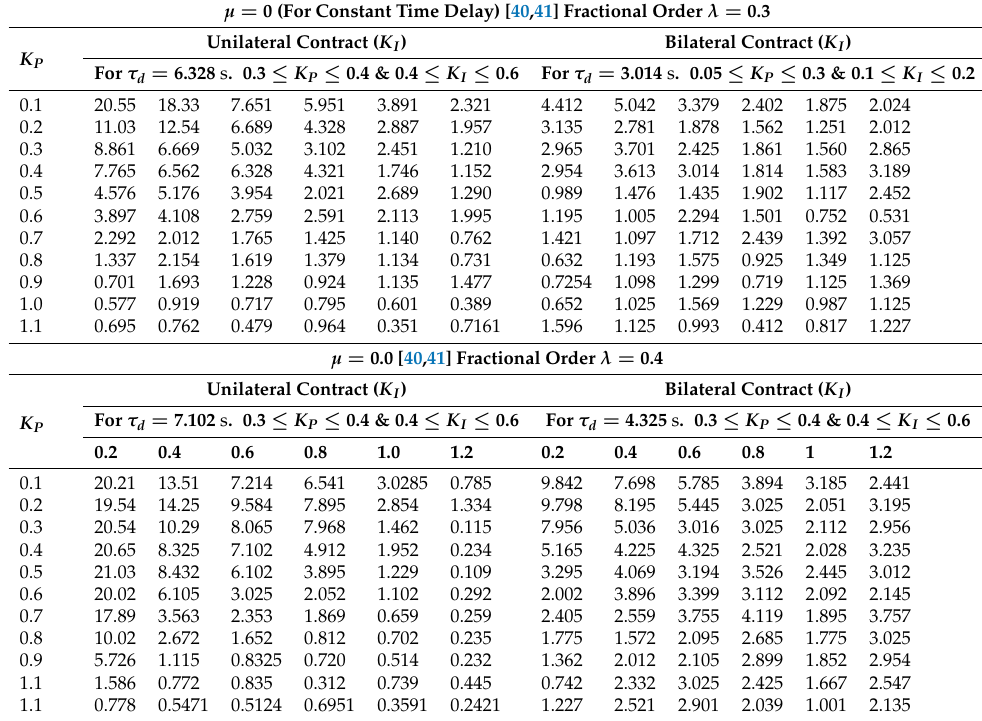
Table 4. Delay margin for proposed FOPI controller for λ = 0.3 and 0.4 µ = 0 (For Constant Time Delay) [40,41] Fractional Order λ =